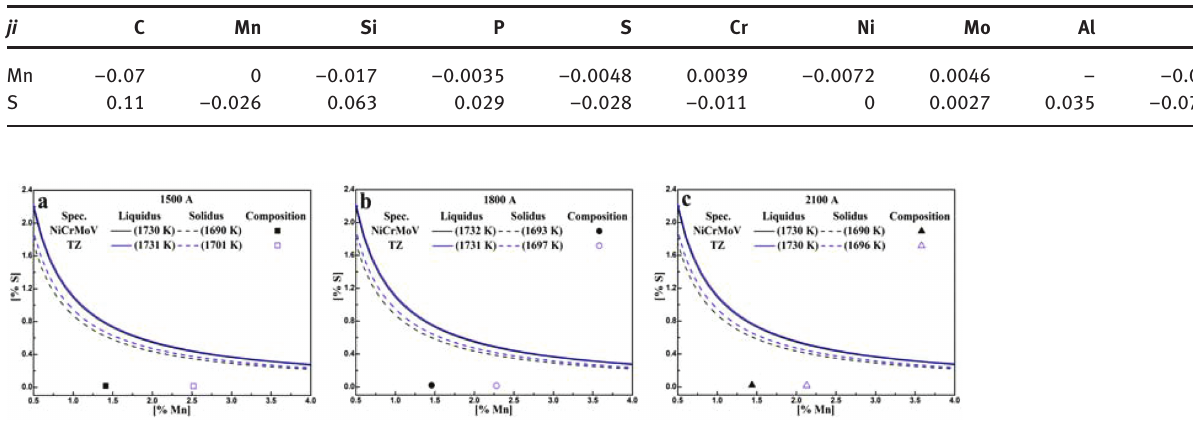
Table 3: Interaction parameters e j i at 1600 o C used in the present study.